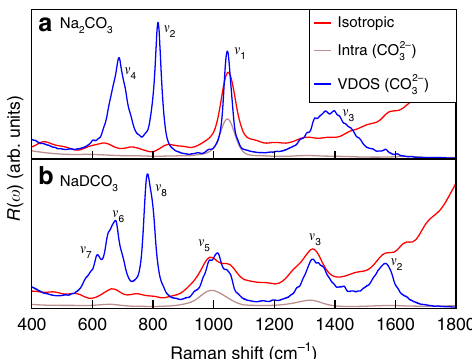
Fig. 5 Zoomed-in Raman spectra of 0.9 molality solutions at ~9 GPa and 600 K. Calculated spectra of the sodium carbonate and deuterated sodium bicarbonate solutions are shown in the upper and lower panels, respectively. The isotropic Raman spectra (red line), the intra-molecular Raman spectra (brown line), and the vibrational density of states (VDOS) (blue line) of CO 2 (cid:1) are compared. 3